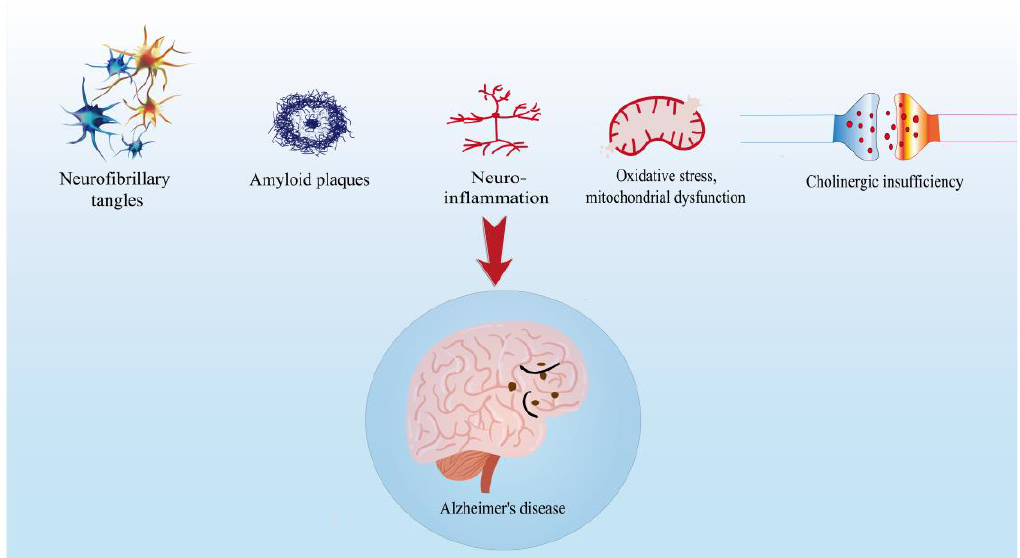
Figure 1. The etiology hypothesis of Alzheimer ’ s disease.